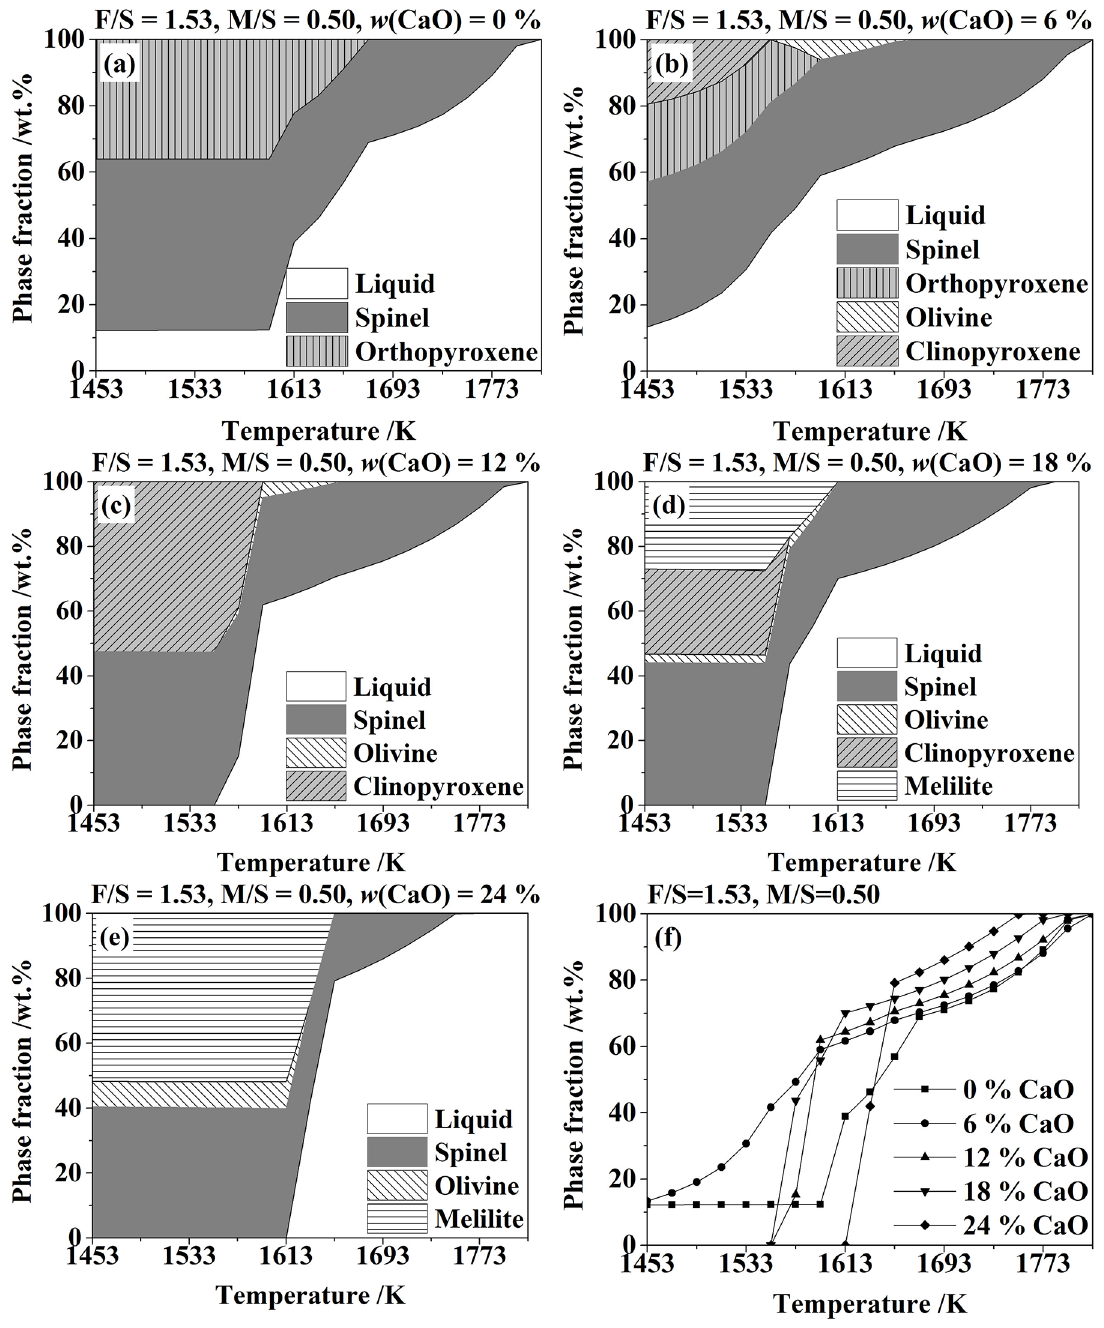
Figure 4. Phase components and liquid fraction at equilibrium state for samples with F/S=1.53 and M/S=0.40. olivine, formed at 12 wt.% CaO and its peaks strengthened with further CaO addition. When w (CaO) was up to 18 %, akermanite (Ca MgSi O ), a member of melilite, could be 2 2 7 obviously discerned. When w (CaO) was up to 24 %, weak peaks of augite could be observed in the XRD patterns. In summary, the theoretical calculations are good agreement with the XRD